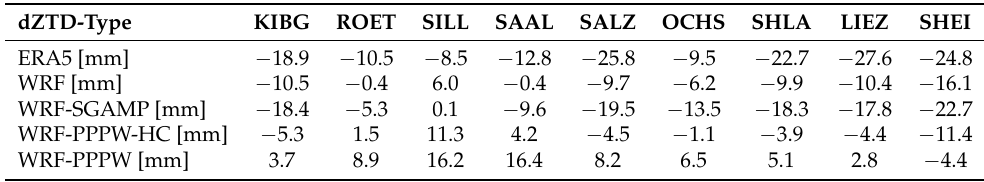
Table 7. Differences between the ZTD estimates from EPOSA stations against WRF-ZTD without (WRF) and with the assimilation of train-borne GNSS-ZTD (WRF-SGAMP, WRF-PPPW-HC, and WRF-PPPW) and ERA-ZTD calculated at the respective